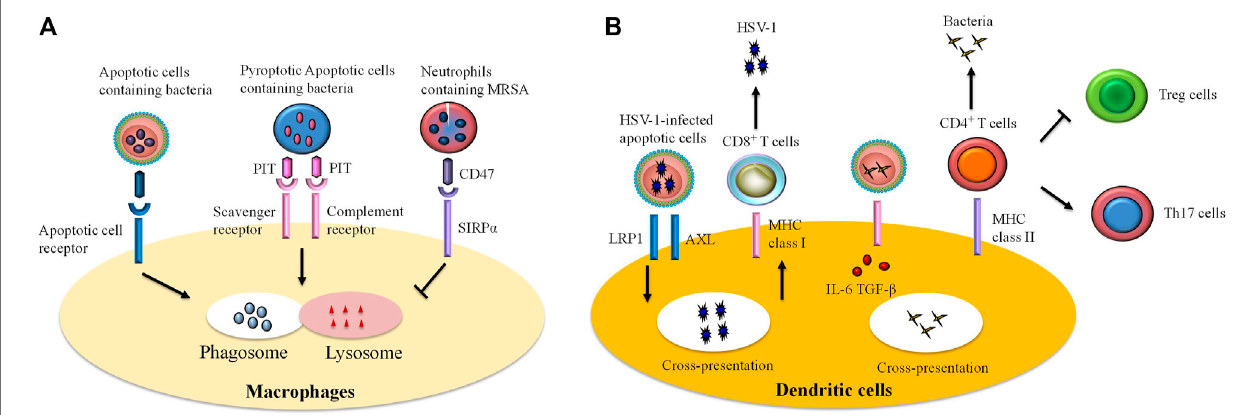
FIGURE 2 | The role of efferocytosis by immune cells in infections. Efferocytosis participates in host defense against invading microbes. However, certain pathogens can escape efferocytosis and accelerate their spread. Efferocytosis is accomplished by professional and unprofessional phagocytes. Remarkably, macrophages and dendritic cells are professional phagocytes that are the most commonly studied of the efferocytes. (A) Ingestion of infected apoptotic cells by macrophages limits secondary necrosis of these cells and bacteria release, thereby improving bacteria clearance. In some cases, certain bacteria can trigger pyroptosis in infected cells. Efferocytotic receptors (i.e., scavenger receptor, complement receptor) are able to recognize pore-induced intracellular traps (PITs) and pytoptotic neutrophil containing bacteria. Subsequently, the process results in bacteria killing via infusion of phagosome to lysosome. However, some pathogens [e.g., methicillin-resistant Staphylococcusaureus (MRSA)]escapeefferocytosisthrough “ tolerateme ” signalCD47andsignalregulatoryprotein α (SIRP α )ontheinfectedcells. (B) Recognition and internalization of some viruses [such as herpes simplex virus type 1 (HSV-1)]-infected cells by dendritic cells interact with RAN-binding protein 9 (RANBP9),low-densitylipoprotein receptor-relatedprotein1(LRP1), and aprotein complexcomprising AXL.Thecrosspresentation ofviralantigenbydendriticcells on MHC class I molecules induces differentiation of CD8 + T cells against viruses. Similarly, dendritic cells swallow infected cells and thereby promote expansion of anti- bacteria effector T cells. In the infected cells, pathogen-associated molecular patterns (PAMPs) signal via Toll-like receptors (TLRs) and stimulate production of transforming growth factor-beta (TGF- β ) and interleukin (IL)-6, thereby expanding the population of CD4 + T cells to T helper (Th)17 cells but inhibiting generation of regulatory T (Treg)